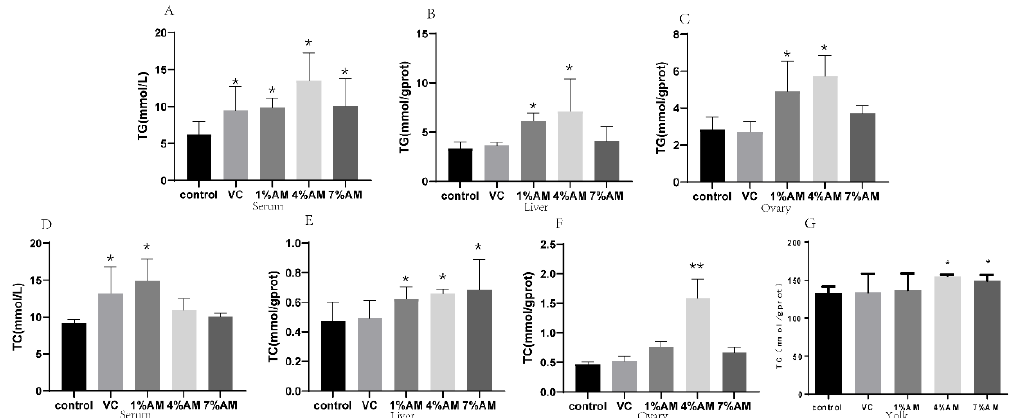
Figure 5. Effects of feed supplemented with AM on TG and TC. TG content in serum ( A ), liver ( B ) and ovary ( C ), TC content in serum ( D ), liver ( E ), ovary ( F ) and yolk ( G ). Values are shown as mean ± SD ( n = 6). Significant differences compared to control group are designated as ** show very significant difference at p < 0.01, * show significant difference at p < 0.05. Abbreviations: TG, Triglyceride, TC, Cholesterol.